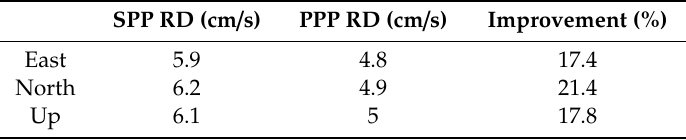
Table 4. RMS statistics and comparison of the ship–borne